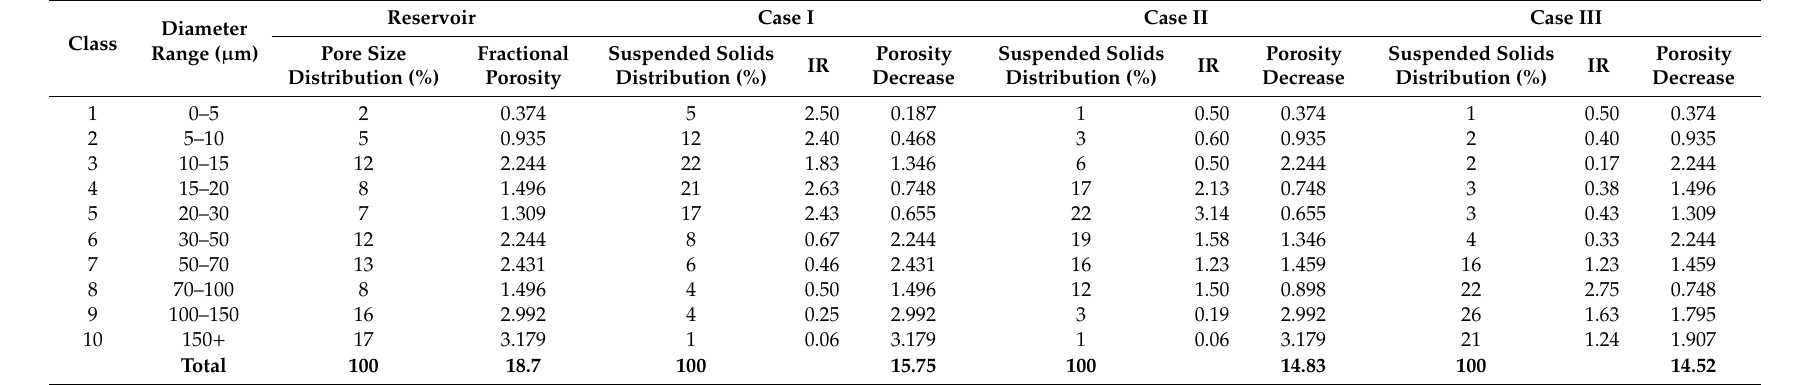
Table 2. Porosity reduction based on impairment ratio (IR) for all three